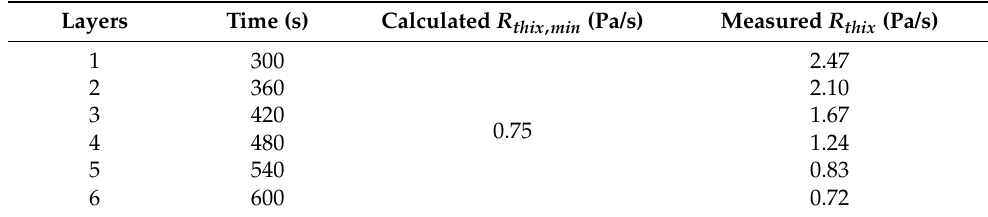
Table 3. Comparison of calculated value and measured value of RST in